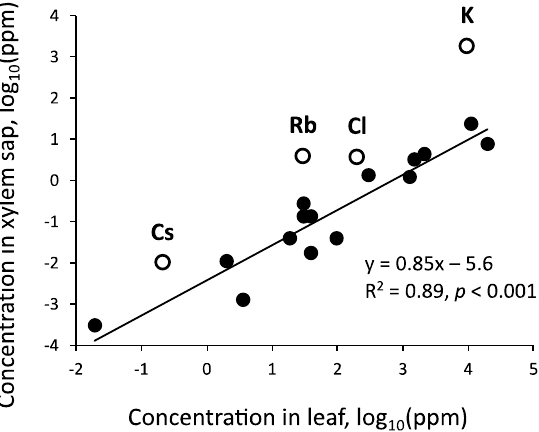
Figure 7. Relationships between the elemental concentrations in the leaves and xylem sap of Q. serrata . The data for K, Rb, Cs, and Cl are not included in the regression line.